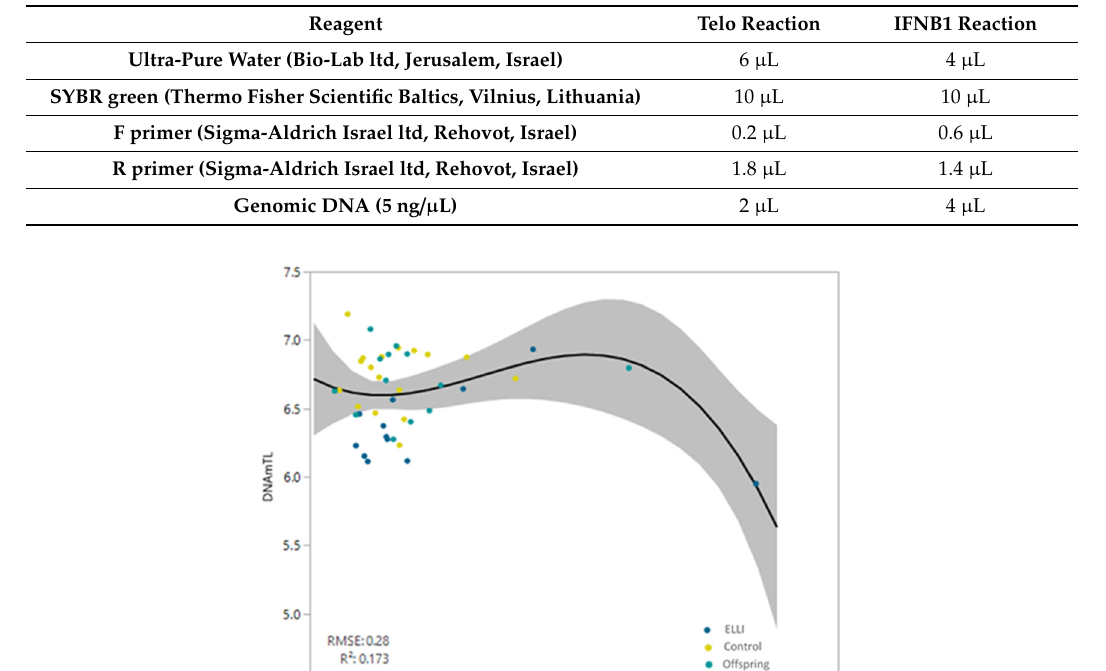
Table A8. Telomere length qPCR reaction volumes per 1 reaction.